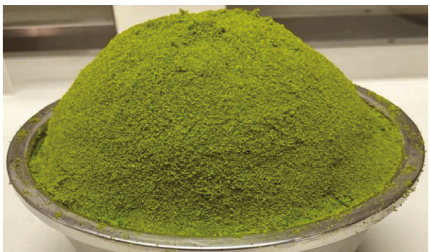
Figure 1: Fresh Wolffia globosa (watermeal, khai nam, or khai